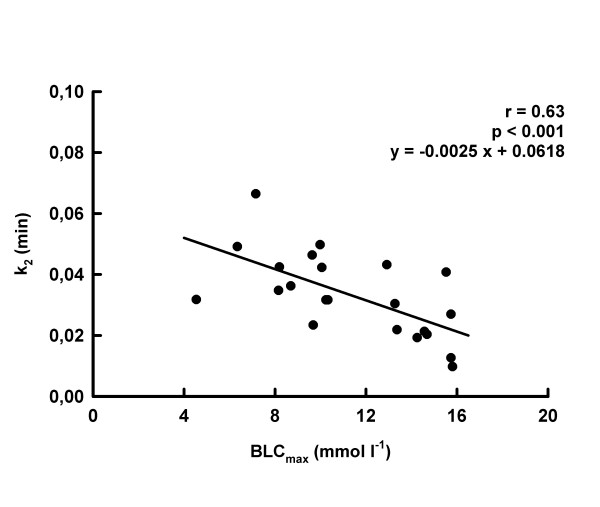
Interrelationship between BLCmax and k2.